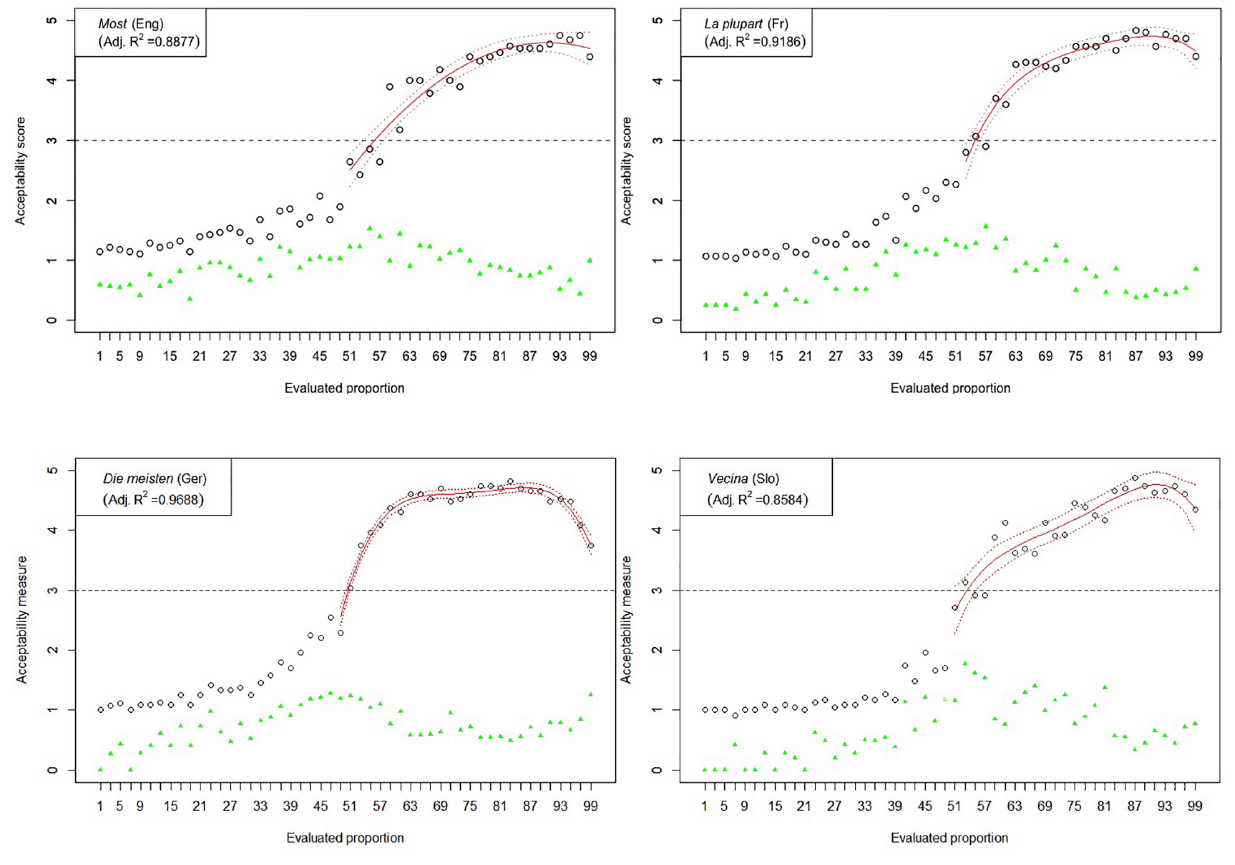
FIGURE 5 | Experiment 1: Mean acceptability scores on most and its cross-linguistic variants in the four tested languages (absolute values of standard deviation for respective means are shown in green), together with respective polynomial fit curves and confidence intervals predicting acceptability in the upper half of the Likert